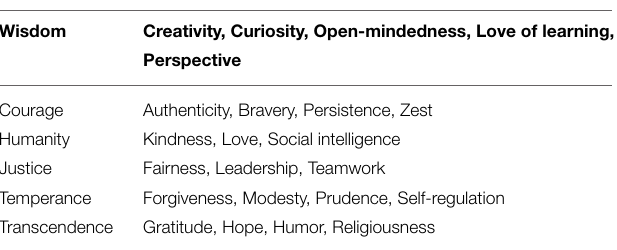
TABLE 4 | Peterson and Seligman’s (2004) “Virtues in Action” classification of